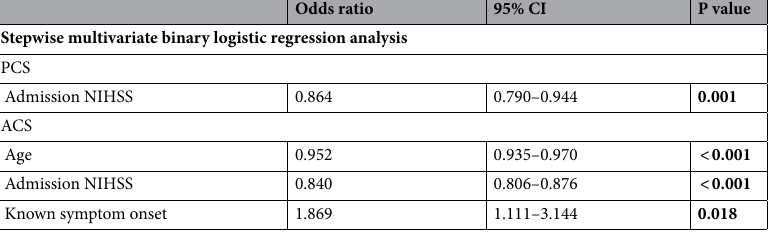
Table 6. Binary logistic regression analysis—predictors for good outcome in PCS and ACS. Multivariate stepwise backward binary logistic regression analysis for outcome in posterior circulation stroke (PCS) and anterior cerebral circulation stroke (ACS), separately. Age, sex, medical history of diabetes, atrial fibrillation, hypertension, dyslipidaemia, smoking, previous stroke or TIA, the admission NIHSS, knowledge of symptom onset and the onset-to-treatment time were examined for their predictive impact on good functional outcome defined as ≤ 2 on the mRS at 90 days. Data are expressed as odds ratios and the 95% CI of the odds ratios. 95% CI indicated 95% confidence interval; NIHSS, National Institutes of Health Stroke Scale. P values < 0.05 are shown in